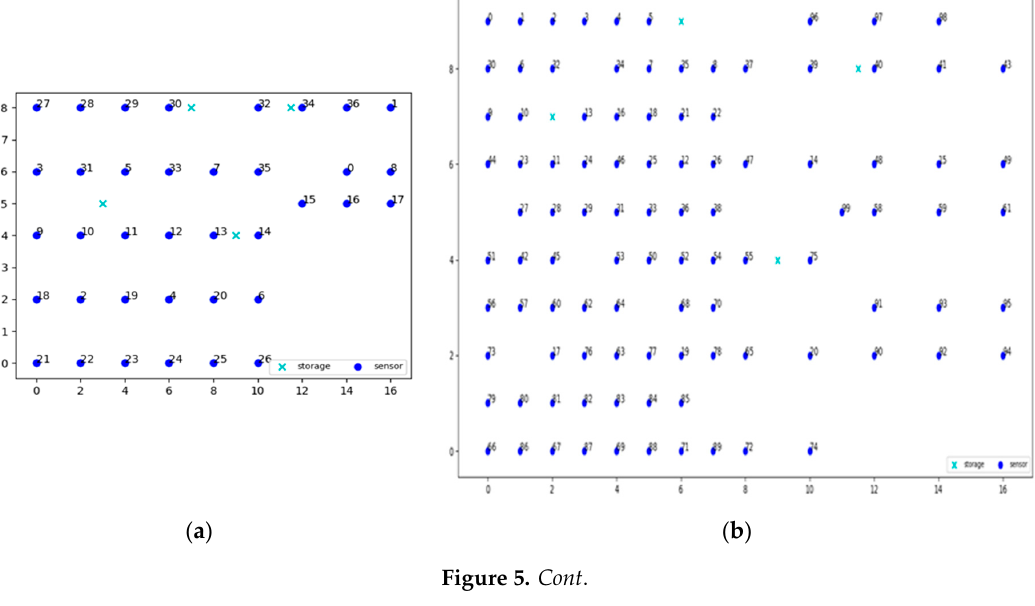
Figure 6. Cont. Figure 5. Cont